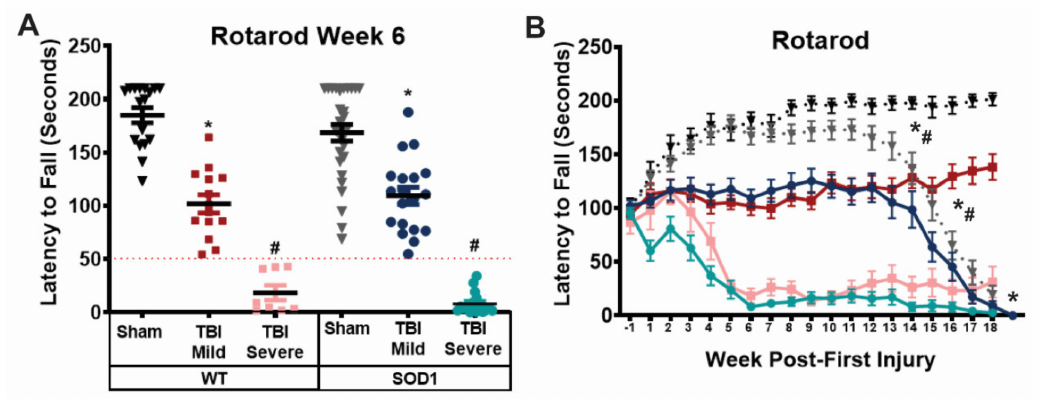
Figure 3. Rotarod performance distinguishes between mild and severe motor deficits resulting from repeat mild TBI. ( A ) TBI rats of each genotype were grouped based on symptom severity at week 6 post-first injury; those with a latency to fall shorter than 50 s on the Rotarod were designated “severe”, while those with a latency to fall longer than 50 s were designated “mild”. (* SOD1 Sham vs SOD1 TBI mild, * WT sham vs WT TBI mild, # SOD1 TBI Severe vs SOD1 Sham and SOD1 TBI mild, # WT TBI Severe vs WT Sham and WT TBI Mild, One-way ANOVA, p < 0 .05) ( B ) When grouped according to symptom severity, both WT and SOD1 animals with mild deficits performed significantly worse than sham animals on the rotarod, while those with severe deficits performed significantly worse than both sham and mild TBI animals of their respective genotype. SOD1 animals exhibited further decline in rotarod performance following disease onset. Deficits were sustained in WT TBI mild and severe animals beyond 21 weeks post-first injury. (* SOD1 Sham vs SOD1 TBI Mild vs SOD1 TBI Severe, * WT sham vs WT TBI Mild vs WT TBI Severe, #SOD1 Sham vs WT Sham, # SOD1 TBI Mild vs WT TBI Mild, Two-way ANOVA p < 0